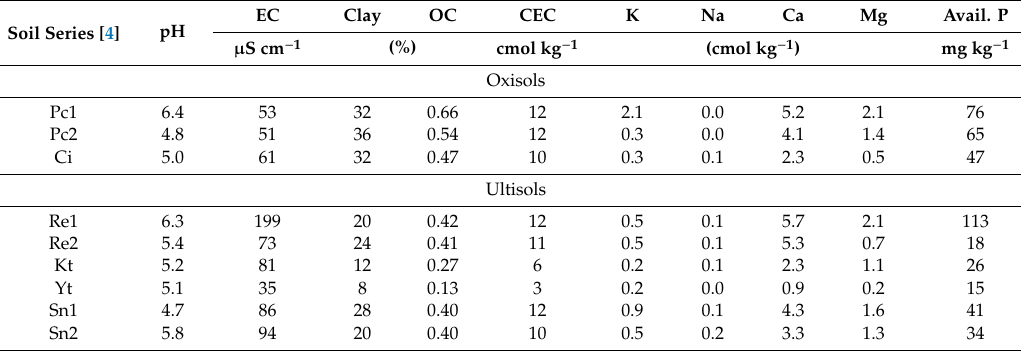
Table 2. Physicochemical properties of the soils used in the